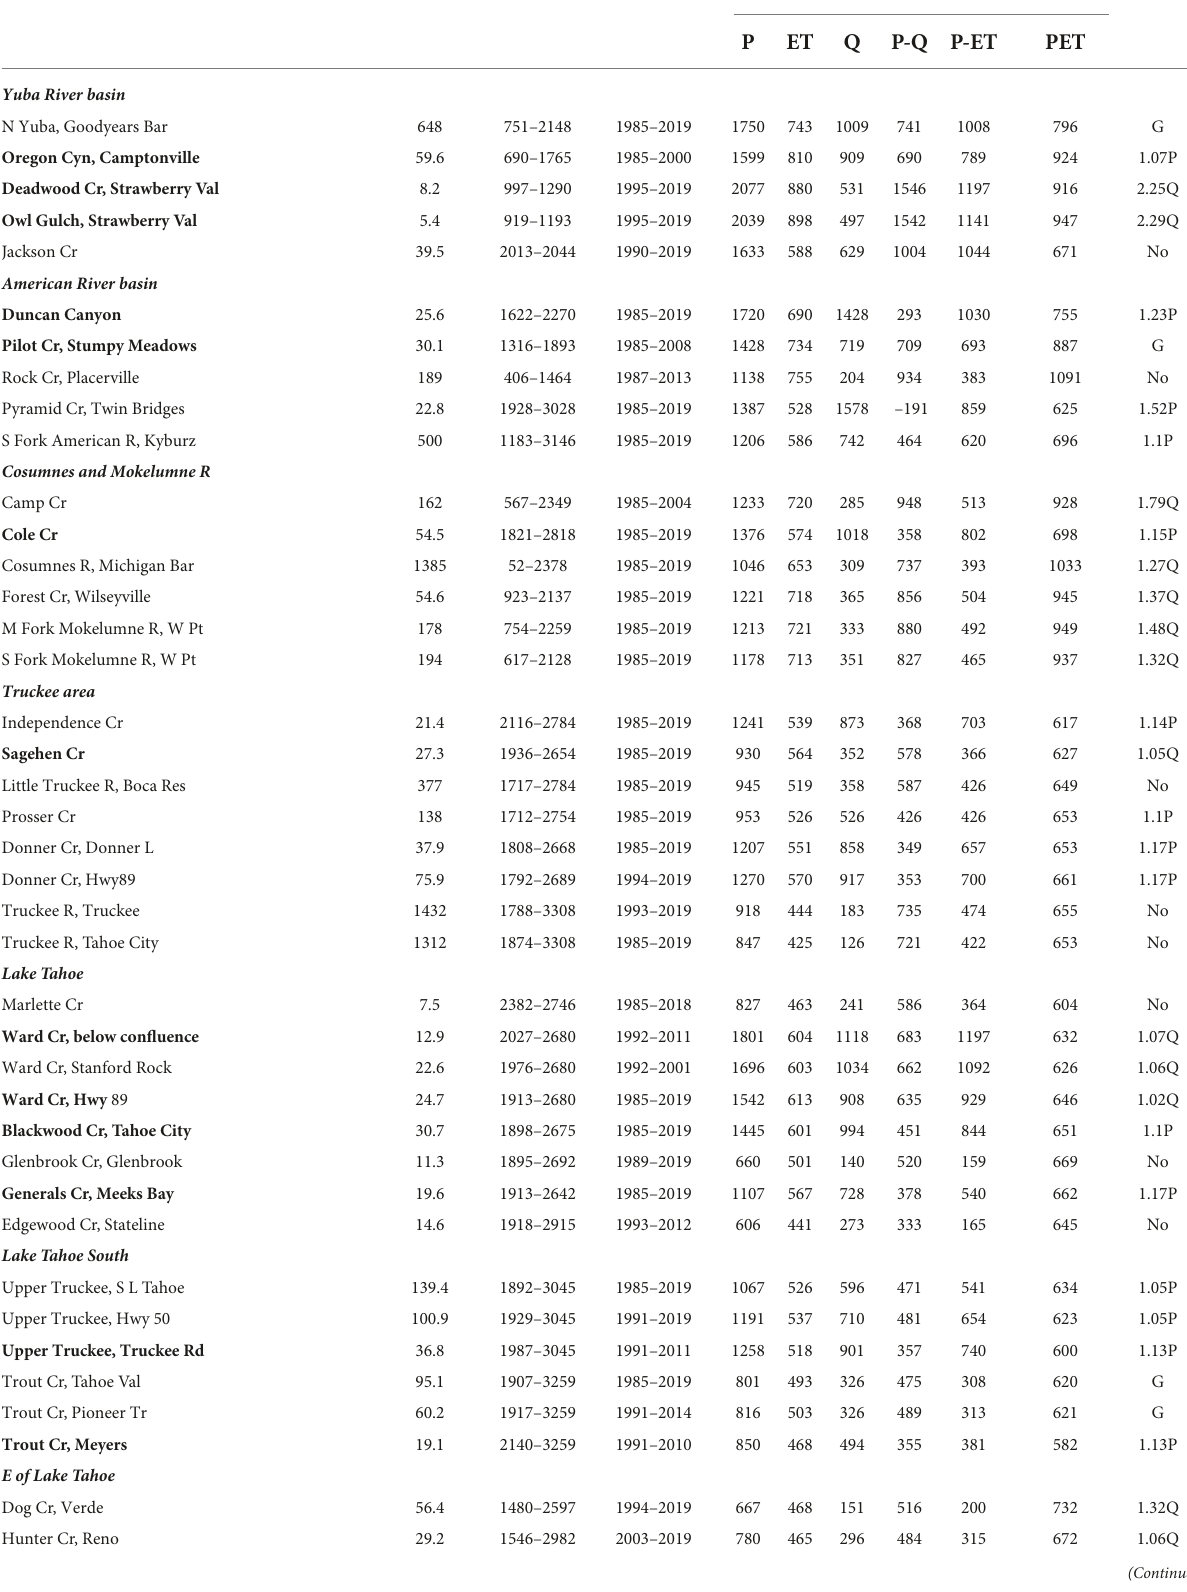
TABLE 1 Attributes of watersheds used in